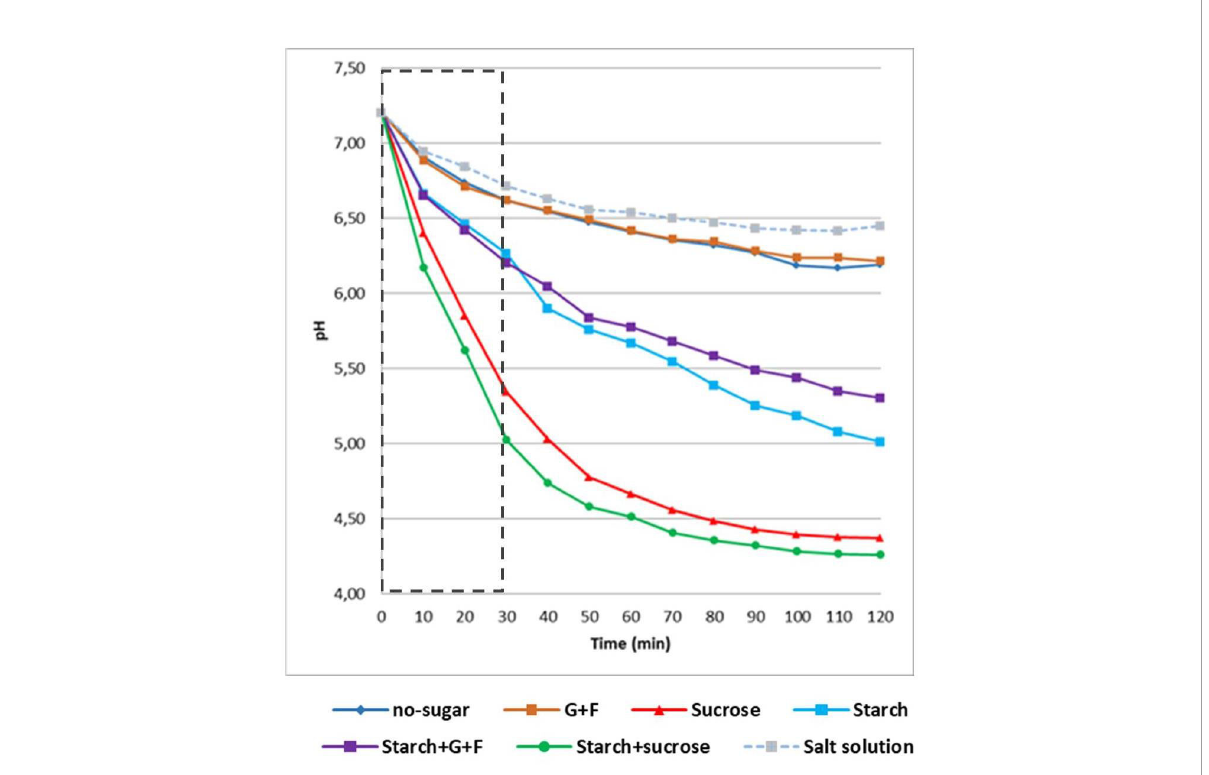
FIGURE 5 Acidogenic pro fi le of bio fi lms originated from different sugar-mediated aggregates. Results of glycolytic pH drop assays (glucose-fermenting). 19h bio fi lms were removed from the culture medium and transferred into a buffer solution containing glucose as the only carbon source. pH of the buffer was measured every 10 min. pH of the fresh culture medium was measured every 2h. Dotted box indicates the data used for proton production analysis (as shown in Table 1). G+F: